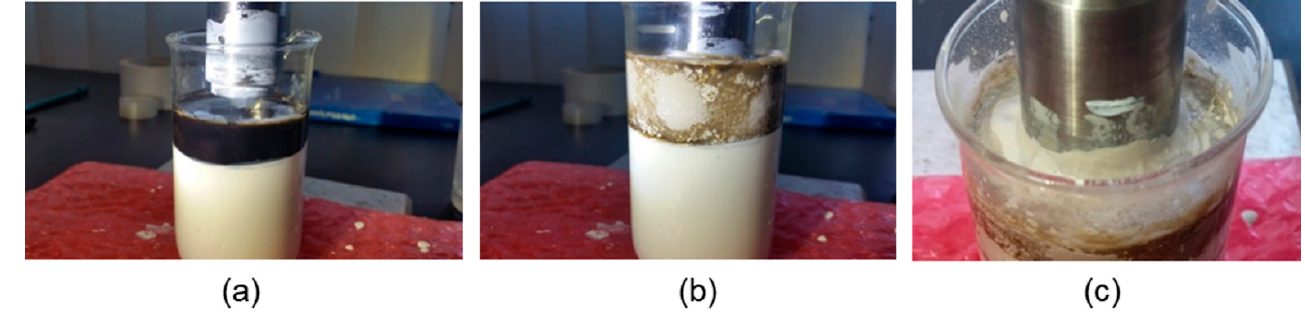
Figure 6. Ultrasound processing steps: ( a ) initial stage; ( b ) processing; ( c ) detail.